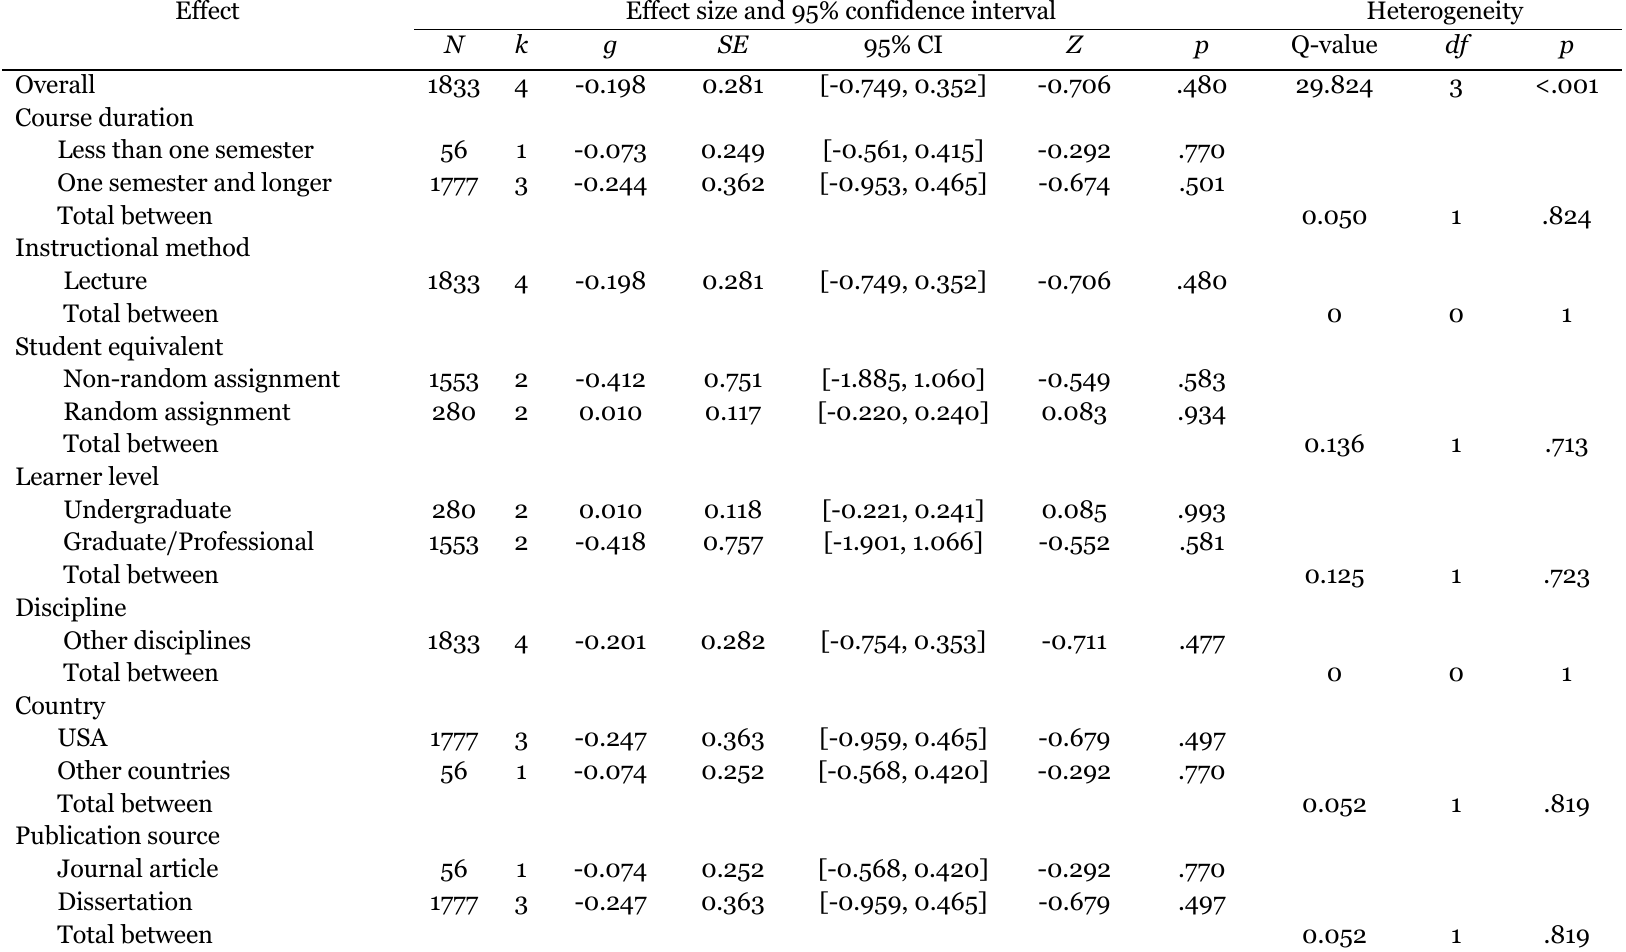
Table C Moderator Analyses (Synchronous vs. Face-to-Face Cognitive